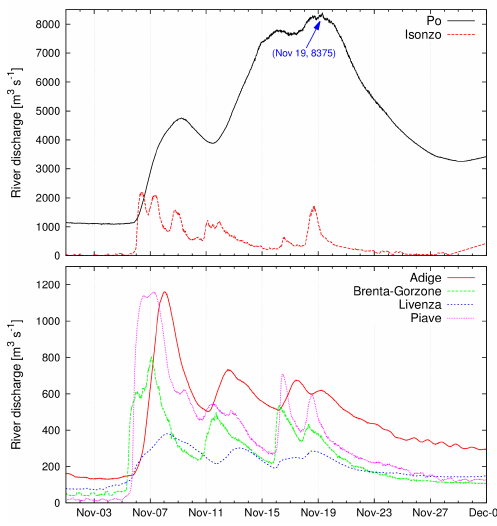
Figure 2. River discharge for November 2014 for the main rivers flowing in